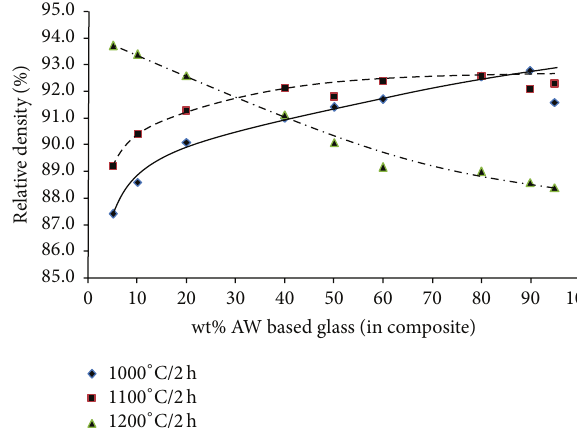
Figure 2: Relative densities of HA-AW